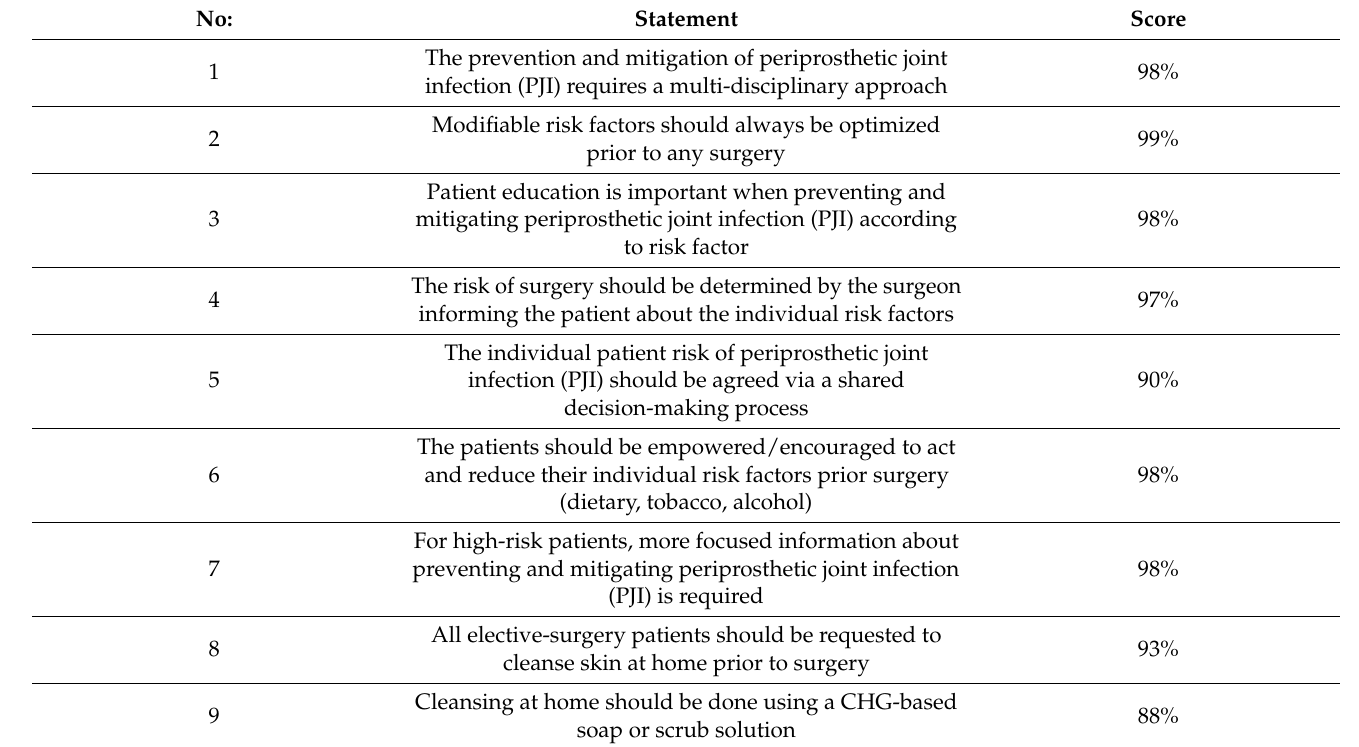
Table 1. Consensus statements and agreement scores on Domain A: preventing and mitigating PJI according to risk